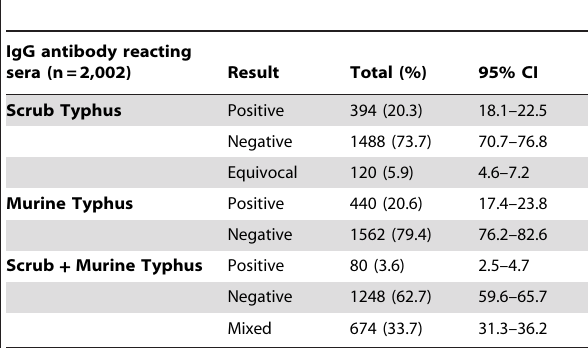
Table 2. Percentage of inhabitants with IgG antibodies against scrub typhus and murine typhus (Vientiane city,